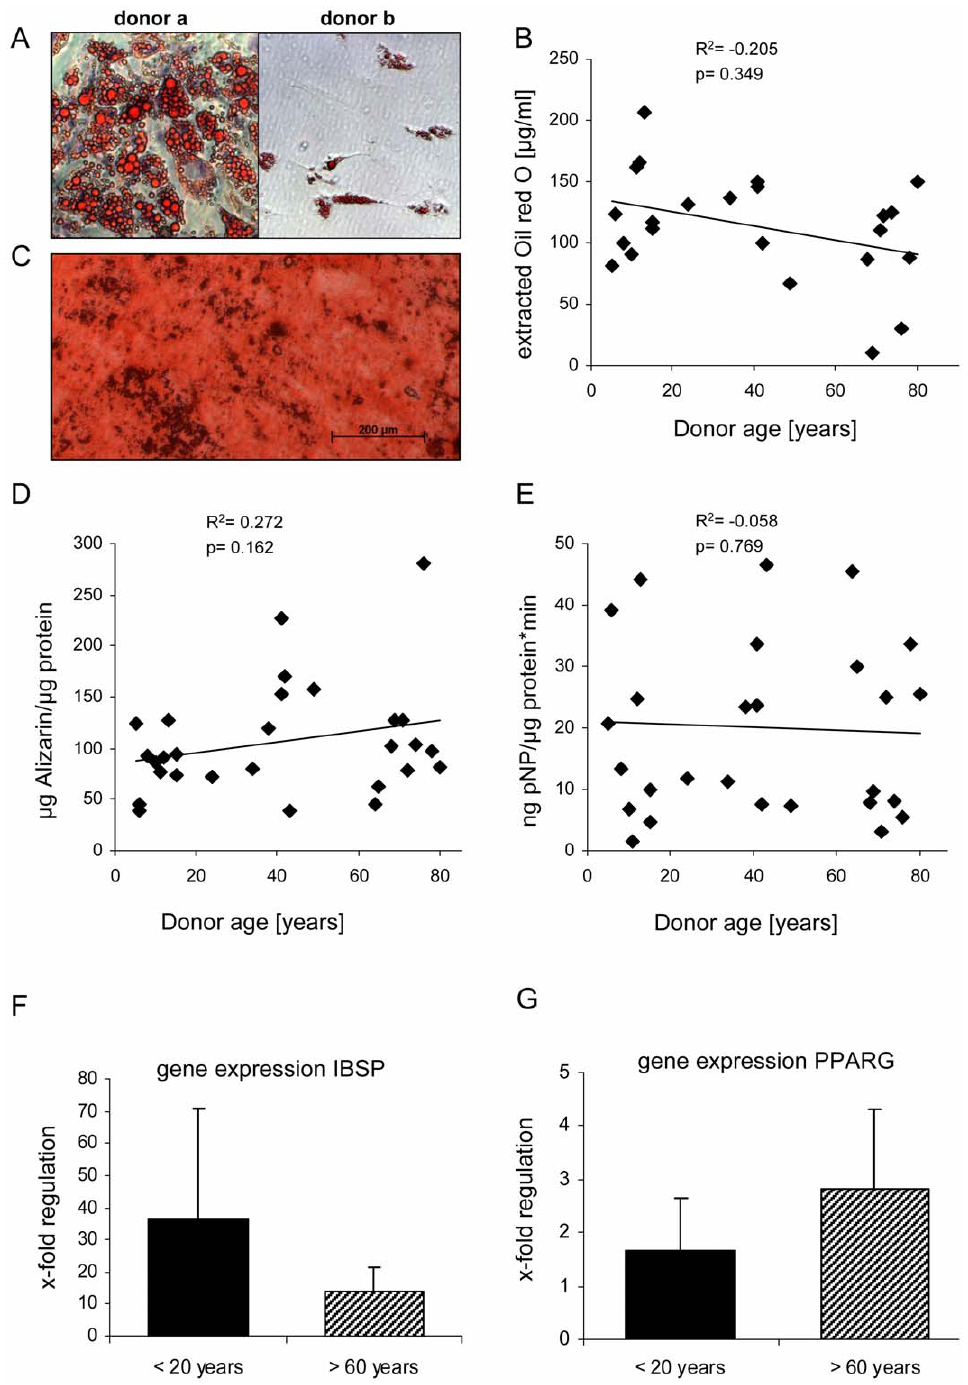
Figure 3. Osteogenic and adipogenic differentiation potential was independent of donor age. Differentiation of MSC (passage 3) was induced with adipogenic or osteogenic induction medium for 21 days in monolayer. (A) Adipogenesis of good (donor a) and impaired MSC (donor b) was detected by Oil Red O staining of the lipid vacuoles and (B) measured by extraction of bound Oil Red O dye. (C,D) Osteogenic in vitro potential was evaluated by quantification of mineral deposition by dye extraction after Alizarin Red staining. (E) Alkaline phosphatase activity of cell lysates was determined using the pNP (para-Nitrophenylphosphate) substrate. No significant correlation of age and differentiation capacity was observed. Correlation was calculated by Spearman-Rho Test. (F) Gene expression of the osteogenic marker Integrin-binding sialoprotein (IBSP) and (G) the adipogenic marker Peroxisome proliferator-activated receptor gamma (PPARG) both normalized to the housekeeping gene GAPDH. Data are given as x-fold regulation compared to undifferentiated control MSC of the same donors. Five of the youngest and the oldest donors of the whole collective were used for analysis in RT-PCR. No difference for both markers was observed between the two age groups (Mann-Whitney-U-Test).